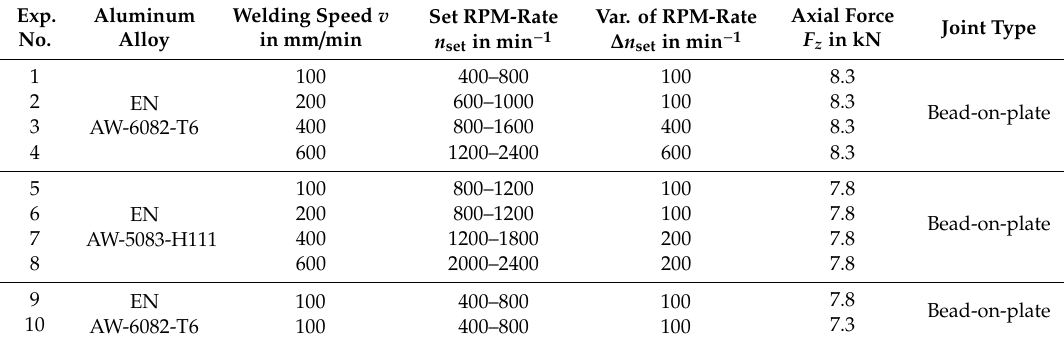
Table 1. Welding parameters of the step response experiments for the validation of the digital twin; the work piece geometry is shown in Figure A2a in the Appendix